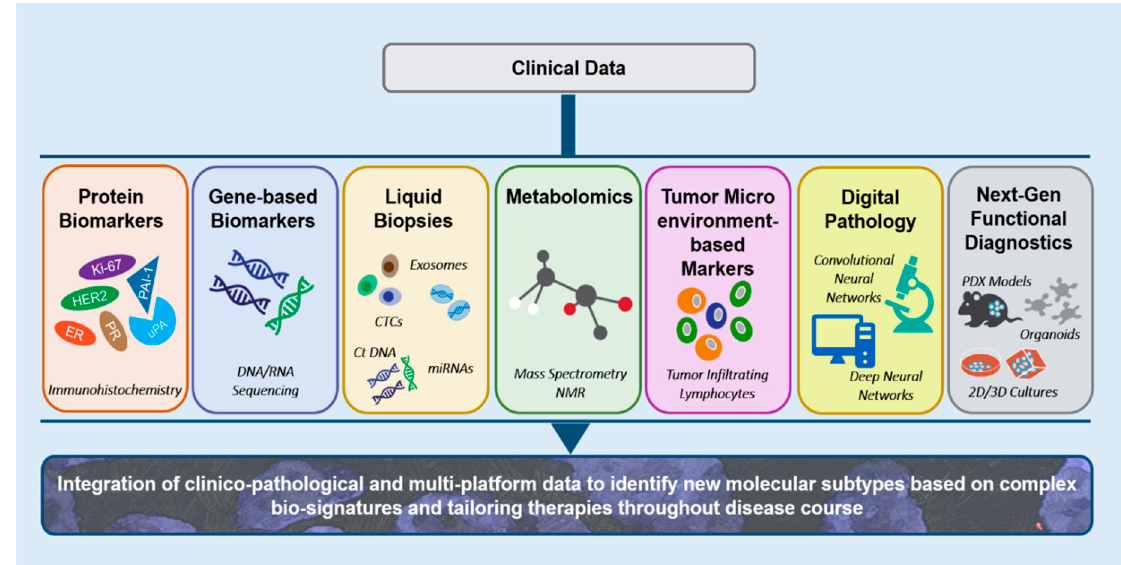
Figure 1. An overview of the various data generating hubs that allows integration of clinico-pathological and multi-omics data. This wealth of information can be meaningfully mined to identify new molecular subtypes based on complex multi-omics generated bio-signatures that can facilitate tailored therapies throughout the disease course in breast cancer patients.